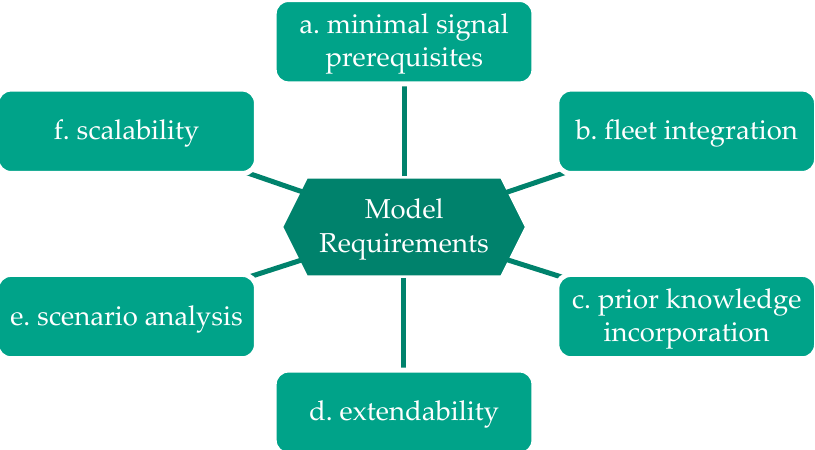
Figure 4. Requirements of the model invoked by automated field data analysis.